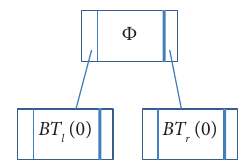
Figure 2: Initializing search binary